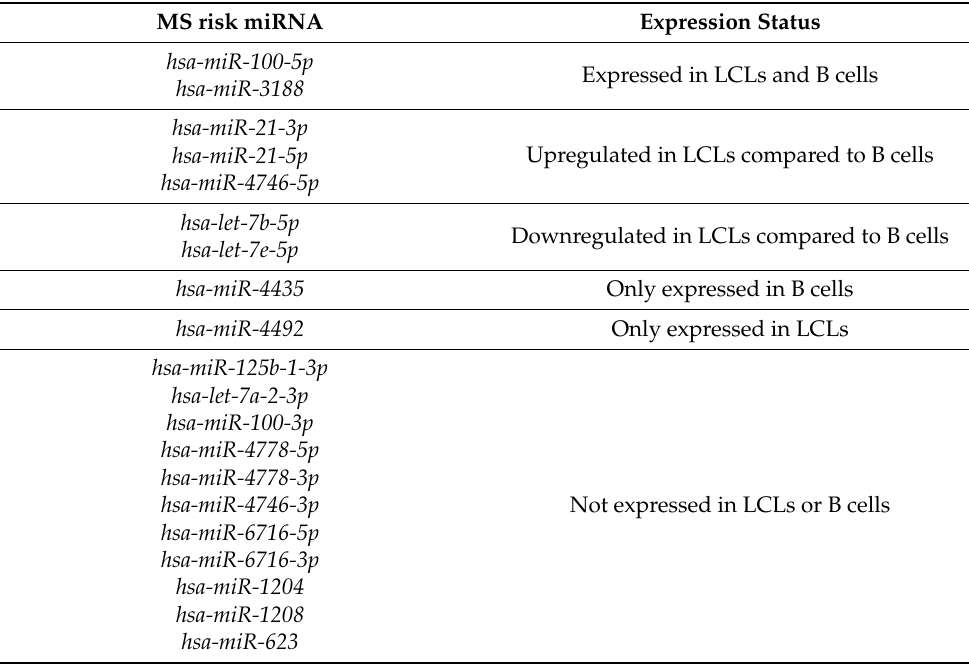
Table 2. MS risk miRNA expressions in LCLs compared to B